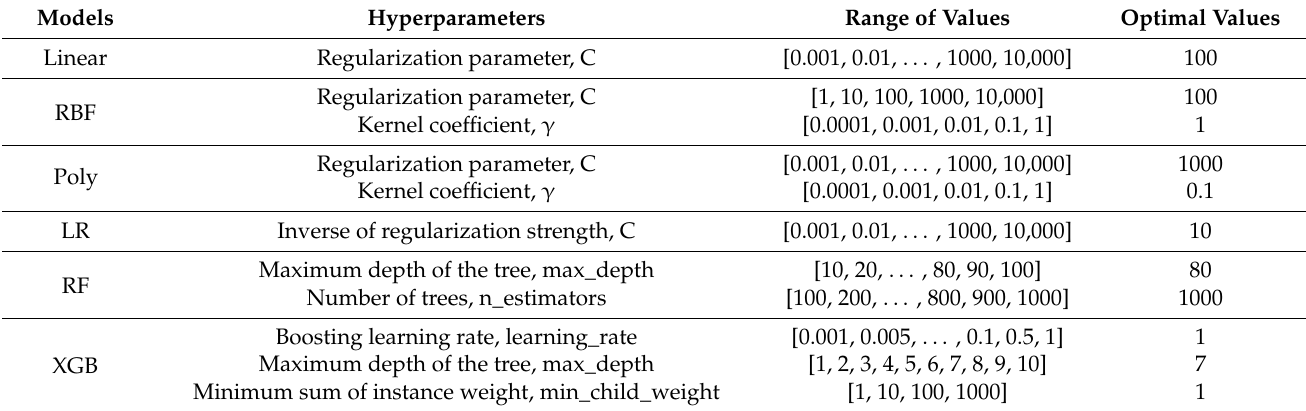
Table 5. Hyperparameter tuning for each classification method (Case